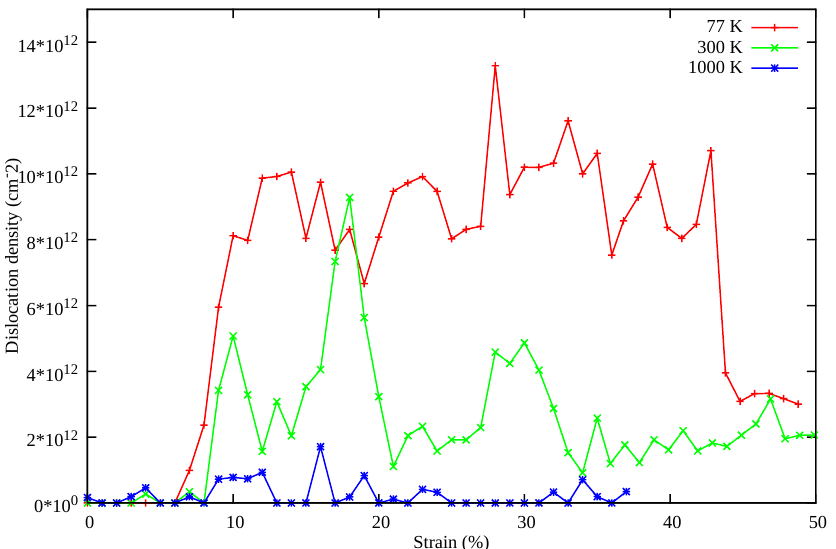
Figure 7. Dislocation density at different temperatures during uni-axial tensile deformation of CoNiCrFeMn HEA